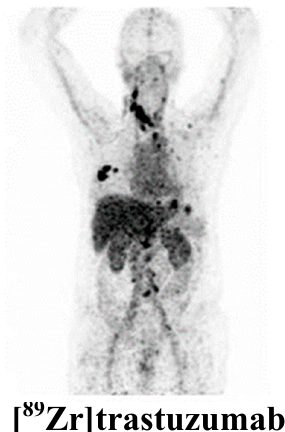
Figure 2. [ 89 Zr]trastuzumab PET scan of a patient with HER2-positive breast cancer. (Figure adapted with permission from Bensch F et al. (2018) [29] Creative Commons Attribution 4.0 International License (http://creativecommons.org/licenses/by/4.0/).